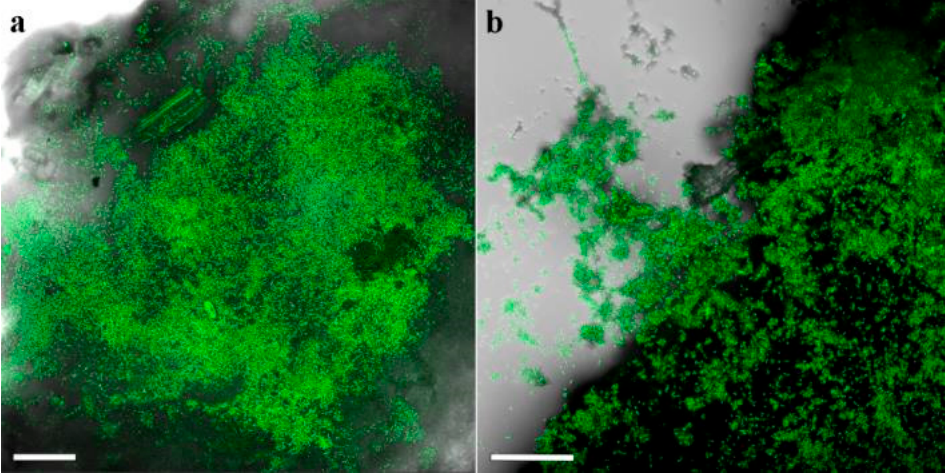
Figure 7. Plant tissue and frass samples from galleries sampled 6.5 months after soil application of EPF: ( a ) Mb7-GFP; ( b ) GHA-GFP. Scale bar = 0.1 mm.